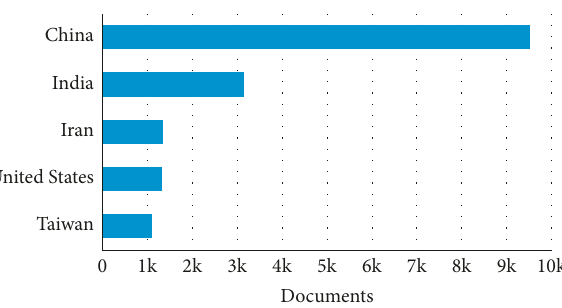
Figure 7: Top countries on PSOA research